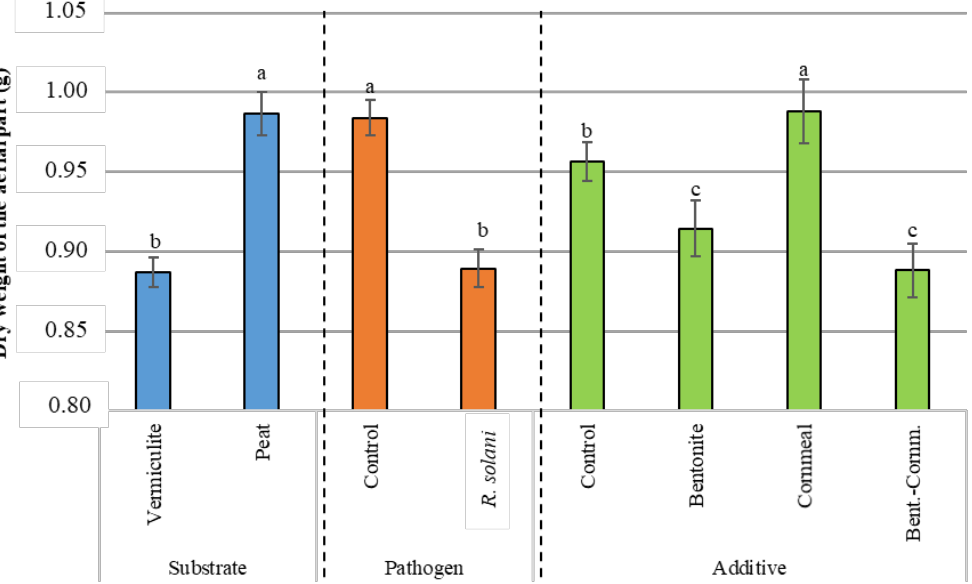
Figure 3. Dry weight of the bean aerial part for substrates, pathogen and additives. Blue colour represents the substrates; orange colour represents the presence or absence of R. solani ; green colour represents the types of additives. Bars of the same colour followed by di ff erent letters are significantly di ff erent ( p ≤ 0.01).